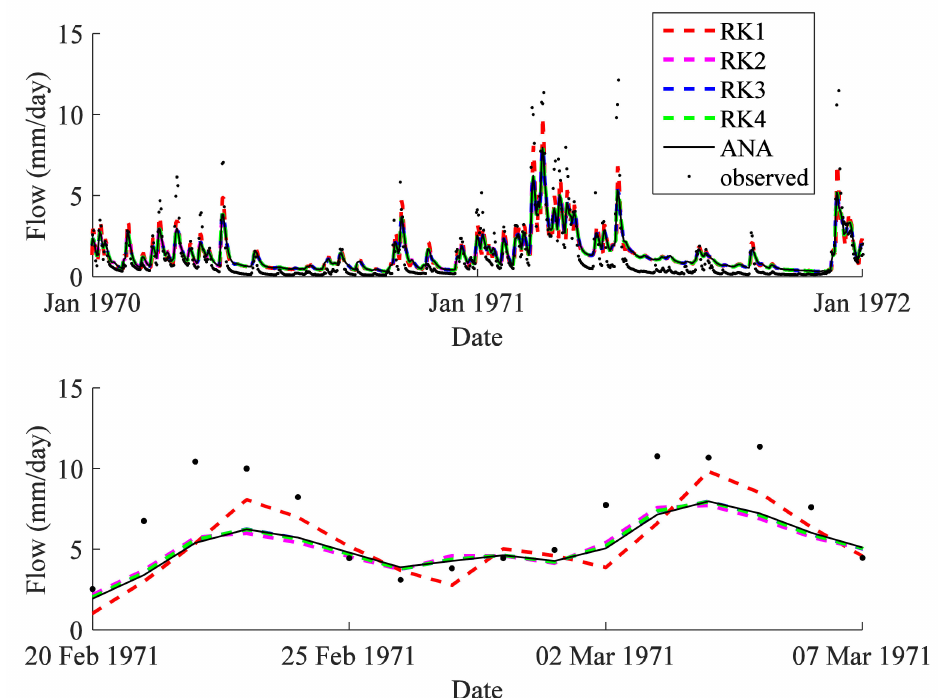
Figure 2. Flow hydrographs simulated with analytical solutions and the explicit Runge-Kutta schemes for: January 1970–January 1972 ( top ) and 20 February 1971–7 March 1971 ( bottom